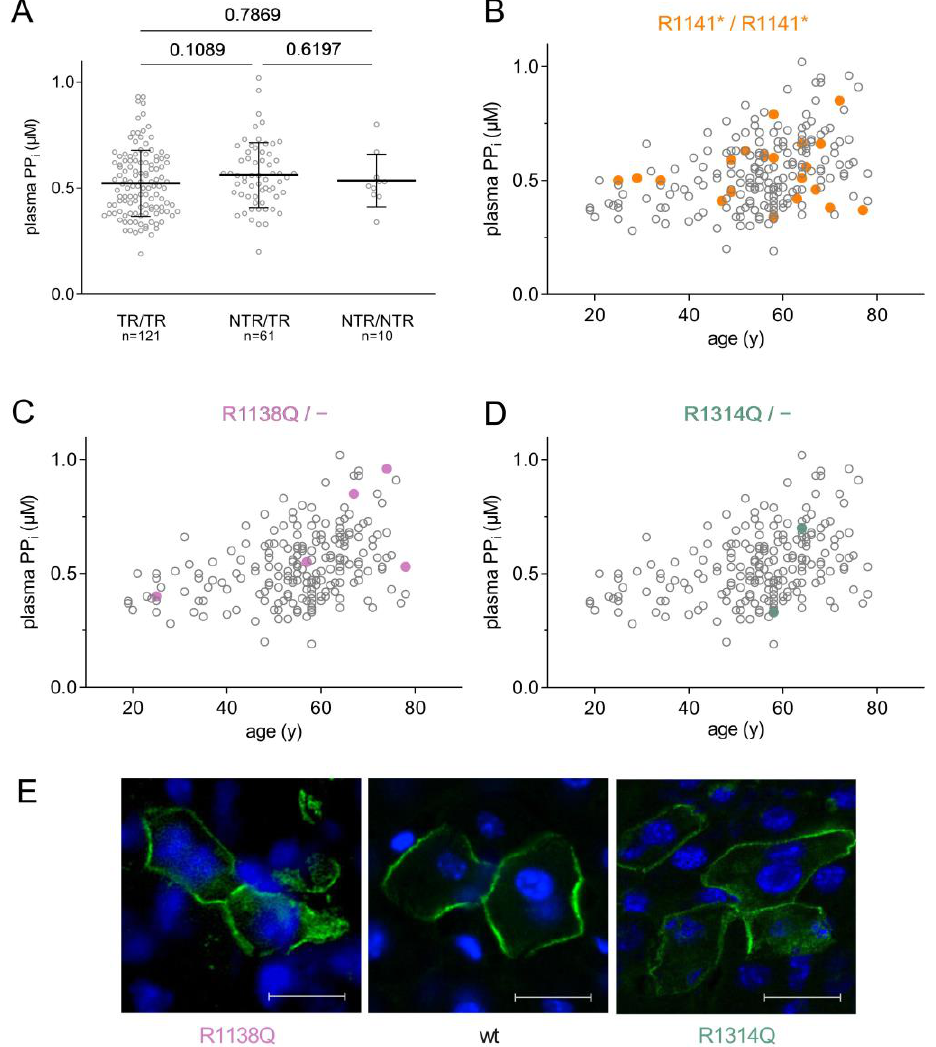
Figure 3. Correlation ABCC6 genotype and plasma PP i . ( A ) Plasma PP i does not correlate with ABCC6 genotype. ABCC6 variants were classified as truncating or non-truncating. Accordingly, three groups of patients were formed: those with truncating mutations on both chromosomes (TR/TR); those with two non-truncating mutations (NTR/NTR), and a third group who had one truncating and one non-truncating ABCC6 mutation (TR/NTR). ( B ) Plasma PP i levels of patients homozygous for R1141* vary between 0.35 and 0.85 µM. R1141* homozygotes are shown on the age vs. plasma PP i plot as orange dots, R1141* homozygous patients from the same family are indicated by squares. ( C ) Patients with the non-truncating R1138Q mutation on one allele and TR on the other allele are highlighted in purple on the age vs. plasma PP i plot; ( D ) patients with the non-truncating R1314Q mutation on one allele and TR on the other allele are highlighted in green. ( E ) Representative images of the subcellular localization of R1138Q, wt and R1314Q ABCC6 protein variants in vivo in the liver of Abcc6 −/− mice [10]; ABCC6 protein is shown in green, and nuclei stained by DAPI are shown in blue (scale bar = 20 µm).